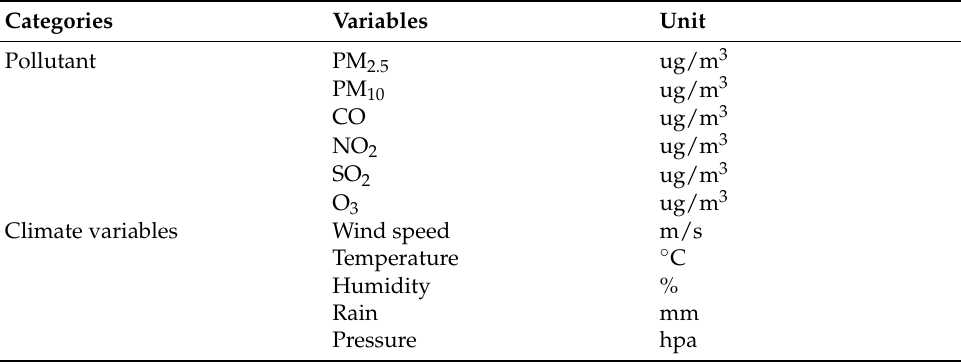
Figure 3. ( a ) Location of Guilin; ( b ) station distribution. Table 1. Pollutants and meteorological variables in the dataset.